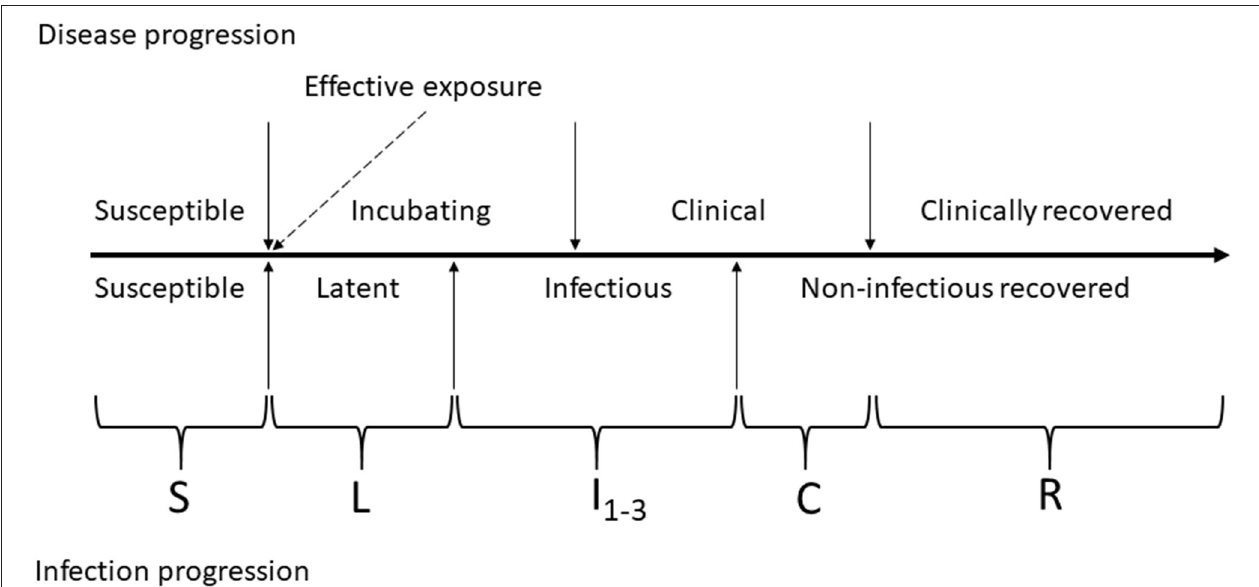
FIGURE 2 | Schematic of foot-and-mouth disease (FMD) infection and clinical disease progression in individual cattle. The compartments of the modified SLIR model of FMD dynamics are indicated by letters: S, susceptible; L, latent; I 1 , subclinical infectious; I 2 , subclinical–infectious; I 3 , clinical infectious; C, clinical but no longer infectious; and R, non-infectious clinically